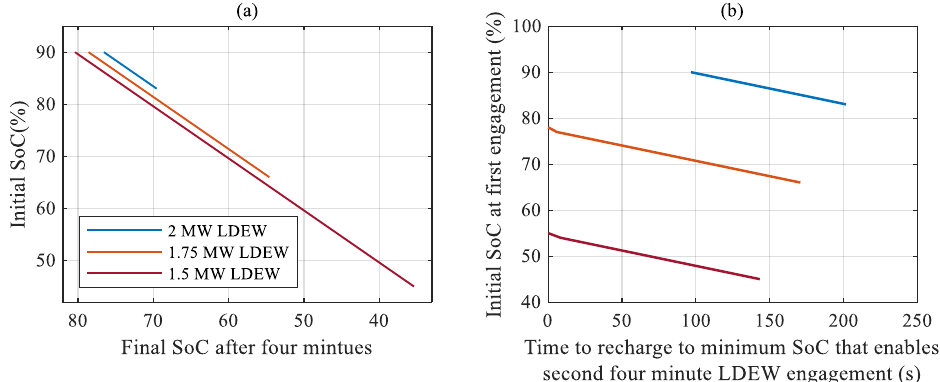
Figure 10. Battery ESS ( a ) final SoC after four minute engagement and ( b ) recharge time to minimum SoC at maximum charging current of 1536 A.